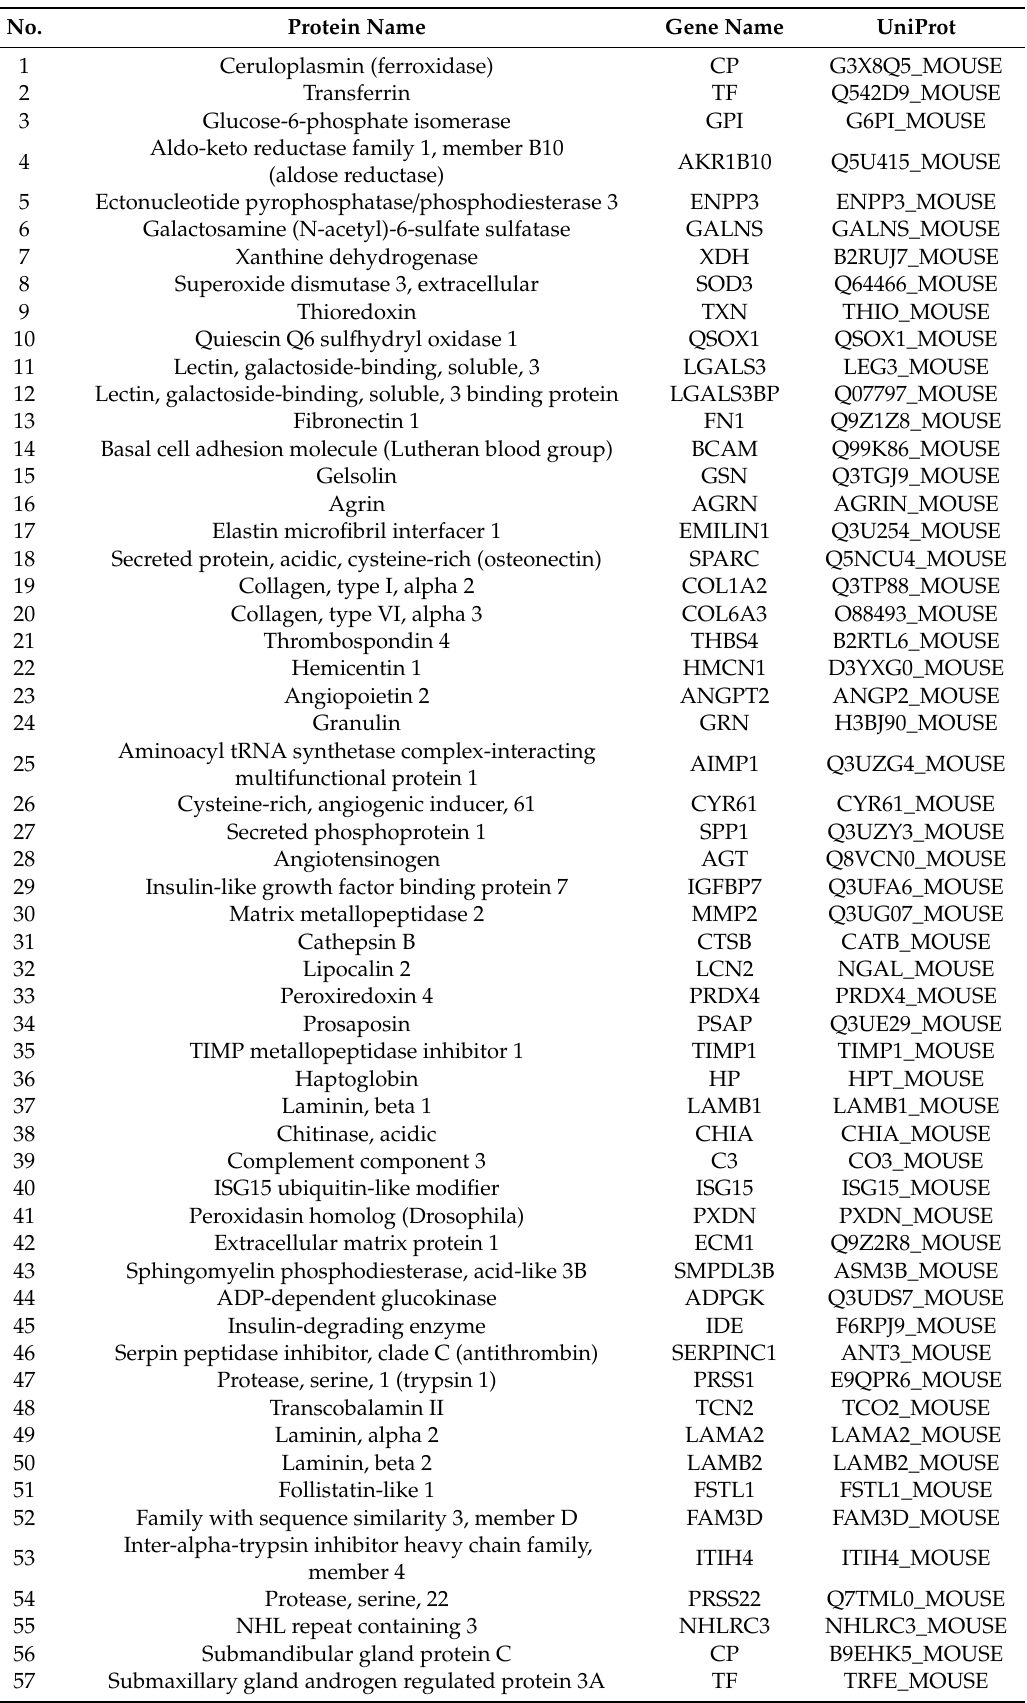
Table 1. Extracellular proteins present in the conditioned media at day 1, identified by the Pathway